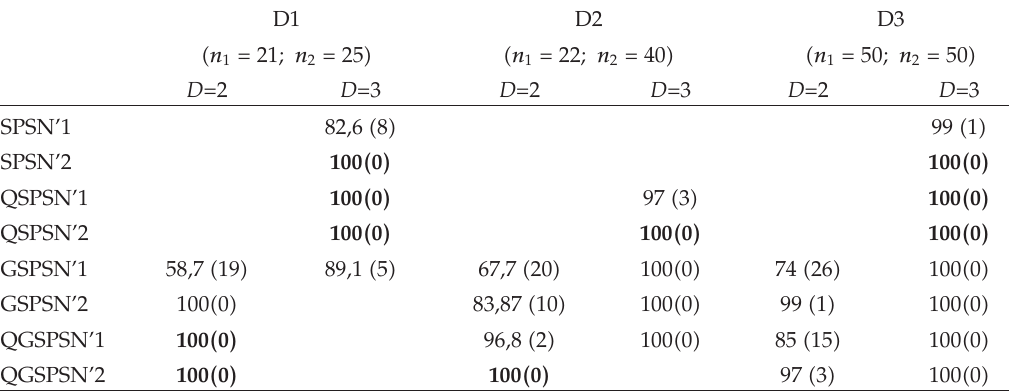
Table 7: Comparison of SPS and GSPS using the N’1 and N’2, normalization